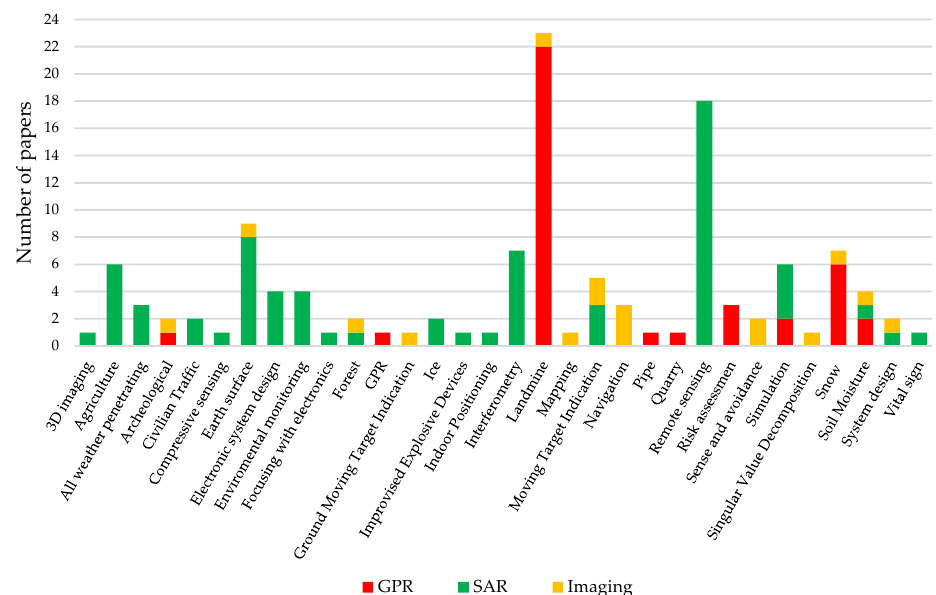
Figure 14. Number of papers per year in terms of specific applications.